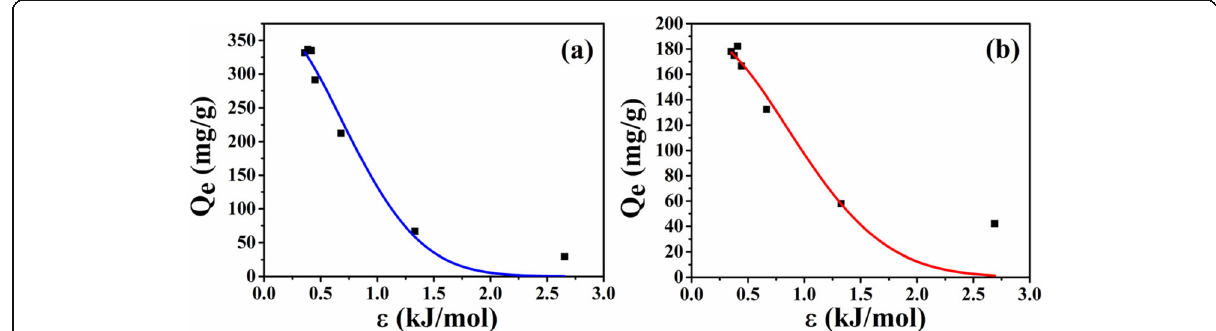
Fig. 9 a Adsorption isotherms model of HEL on ATP-CG microspheres. b Adsorption isotherms model of HEL on ATP-CL